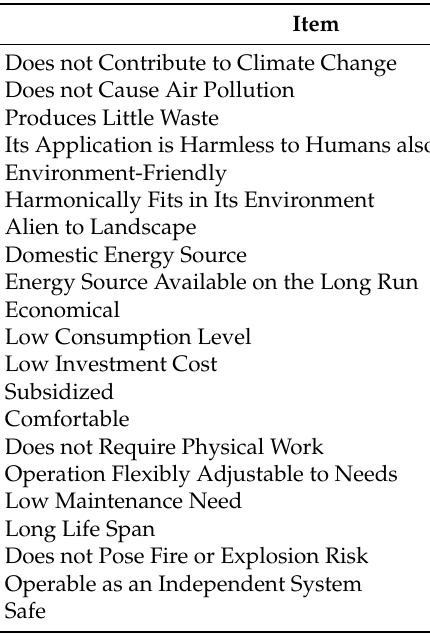
Table 2. Mindsets on heating energy generation methods—items used in the pairwise